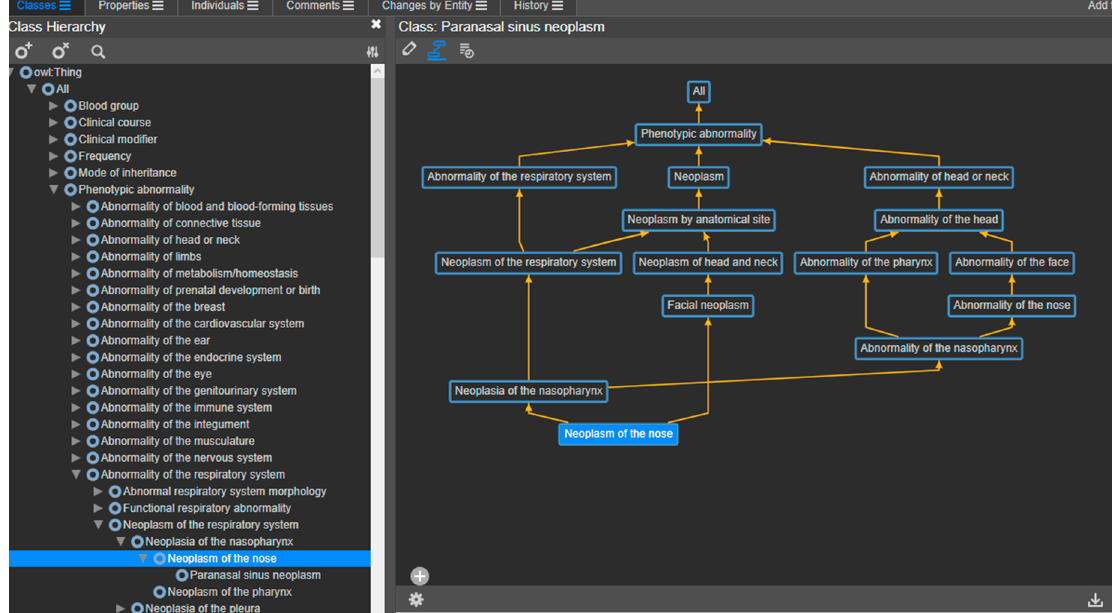
Figure 5. WebProtégé Entity Graph: List and context subviews. Source: Image with permission courtesy of Center for Biomedical Informatics Research, Stanford University School of Medicine, Protégé Team, https://protege.stanford.edu.